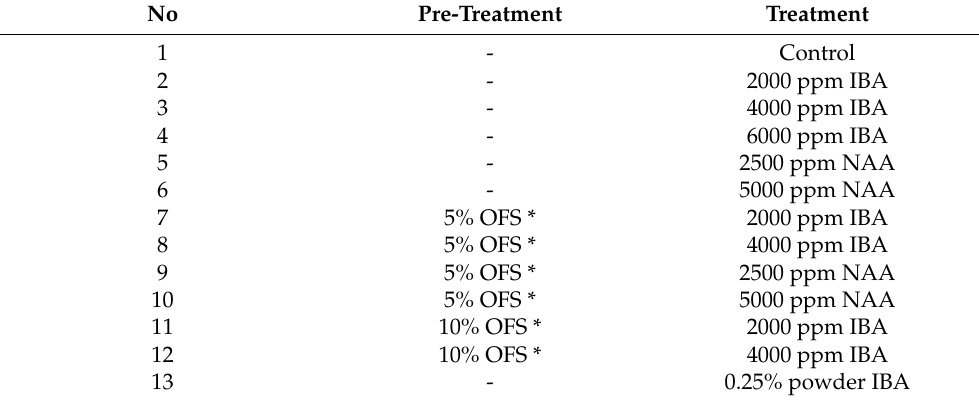
5% OFS * 2500 ppm NAA 5% OFS * 5000 ppm NAA 10% OFS * 2000 ppm IBA 12 10% OFS * 4000 ppm IBA 13 - 0.25% powder